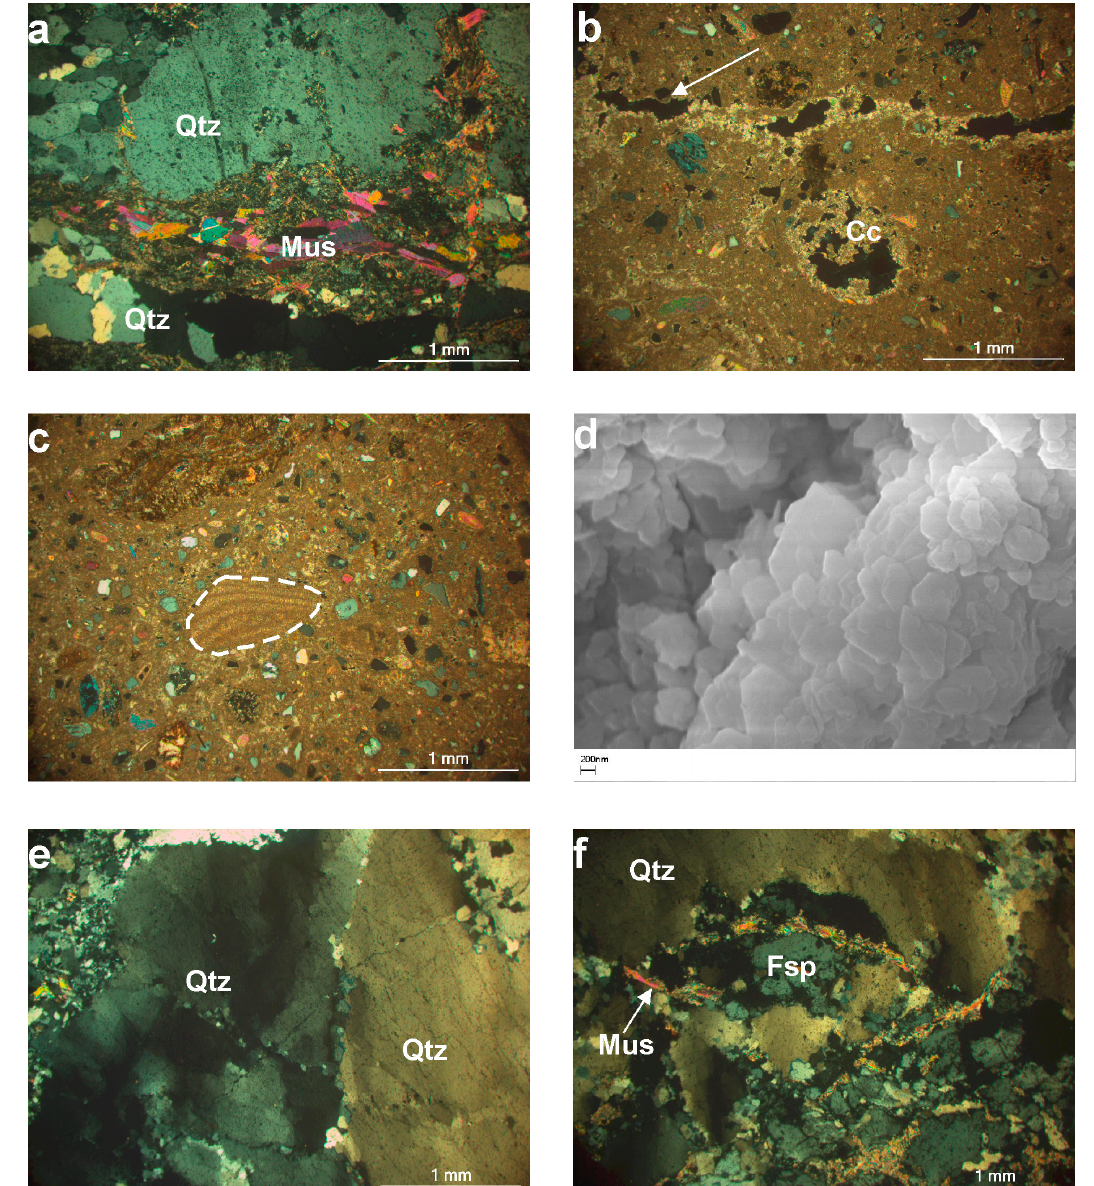
Figure 8. ( a ) Photomicrograph of mica schist shows granoblastic of quartz (Qtz) and lepidoblastic texture of muscovite (Mus) (sample of area 3, XPL); ( b ) Photomicrograph of fossiliferous limestone where endoclasts of quartz, muscovite and channel type of porosity locally filled with recrystallized calcite (Cc) are observed in a micritic matrix (sample of area 4, XPL); ( c ) Photomicrograph of fossiliferous limestone where fossils and endoclasts of quartz, muscovite and Fe oxides are observed in a micritic matrix (sample of area 4, XPL); ( d ) SEM image of kaolinite (or chlorite) showing the characterized pseudohexagonal shape of their crystals (sample of area 4); ( e ) Photomicrograph of quartz (Qtz) with intense undulate extinction in a pegmatite (sample of area 5, XPL); ( f ) Photomicrograph of large crystals of quartz (Qtz), feldspar (Fsp) and fine-grained muscovite (Mus) in a pegmatite (sample of area 5, XPL).